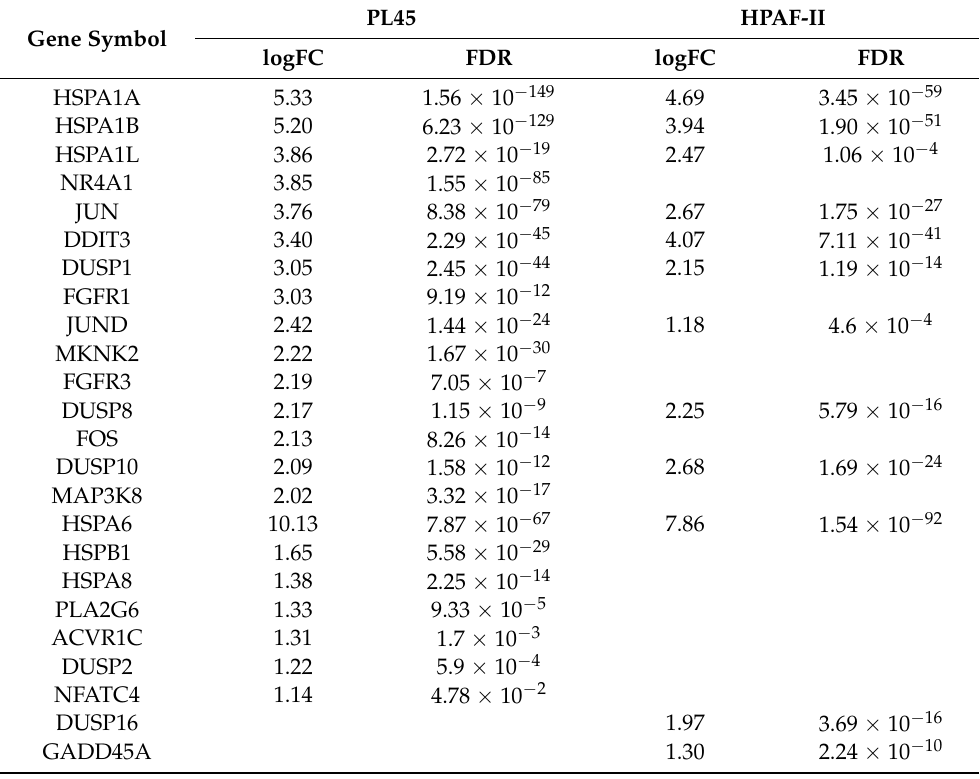
Table 2. Upregulation of MAPK signaling pathway-related genes in PL45 and HPAF-II cells following the treatment with CSE (FDR-adjusted q-value <